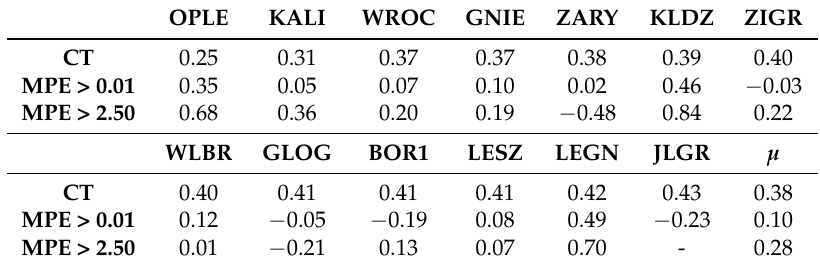
Table 4. Correlation coefficients between ZTD differences and CT and MPE products at 13 GNSS stations.